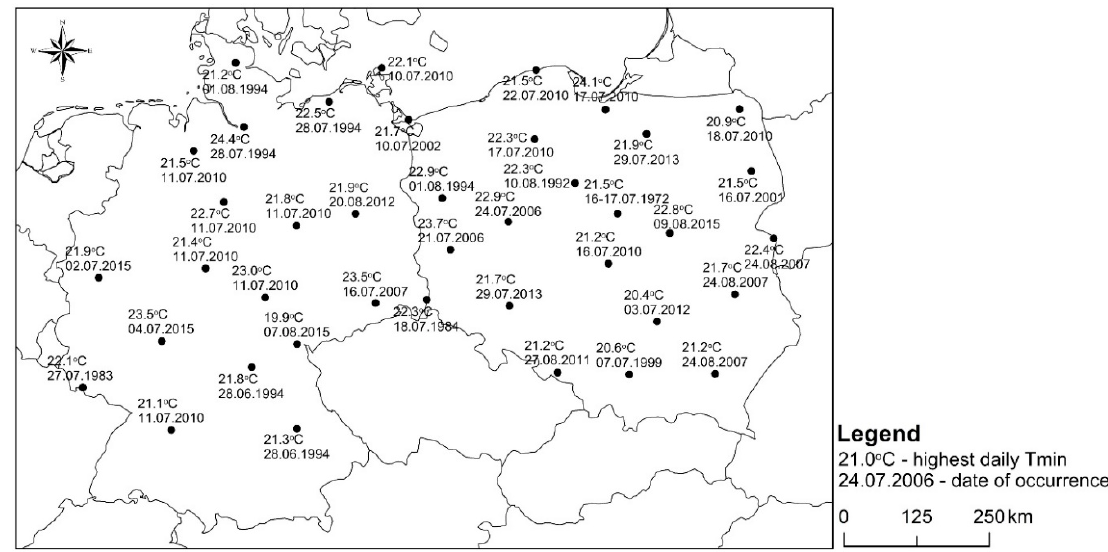
Figure 5. Highest daily T min recorded during (June–August) hot nights in the summers 1966–2015 with the date of its occurrence.